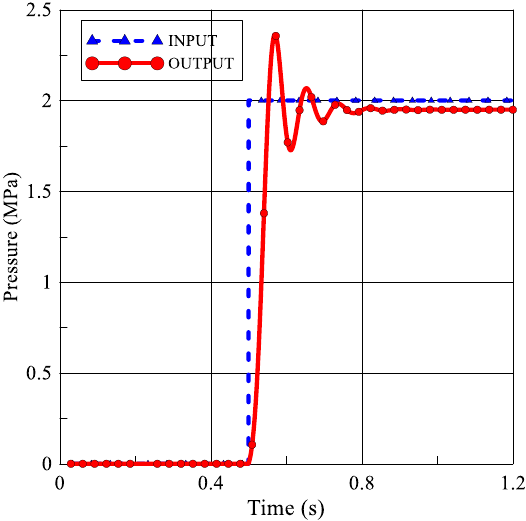
Figure 5. The 2D digital buffer valve’s step characteristic curve.